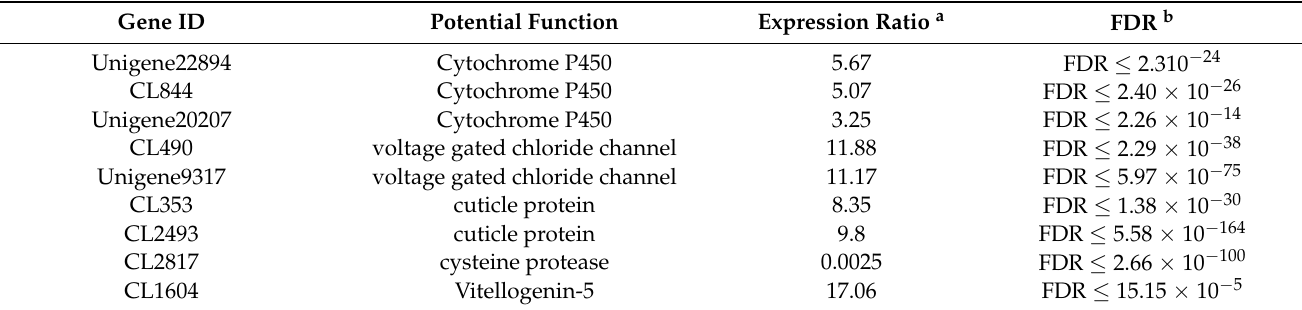
a The average expression ratio (Expression resistant /Expression susceptible ) in the four comparisons made (in the two susceptible samples versus the two resistant samples). b The maximal FDR value in the four comparisons made. The FDR level was calculated using the significance of digital gene expression profiles [41].